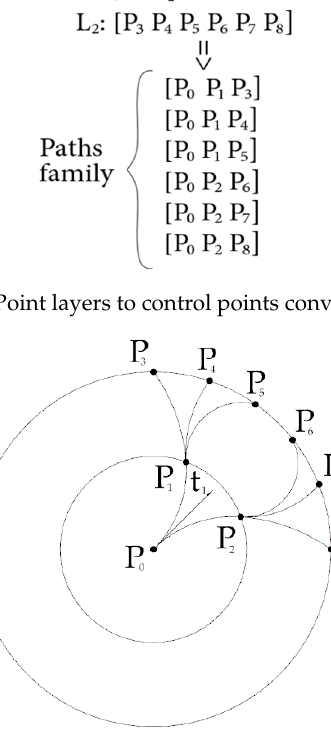
Figure 9. Layers parameters: P—number of points, A—angle ranges, L—layers radii [22].